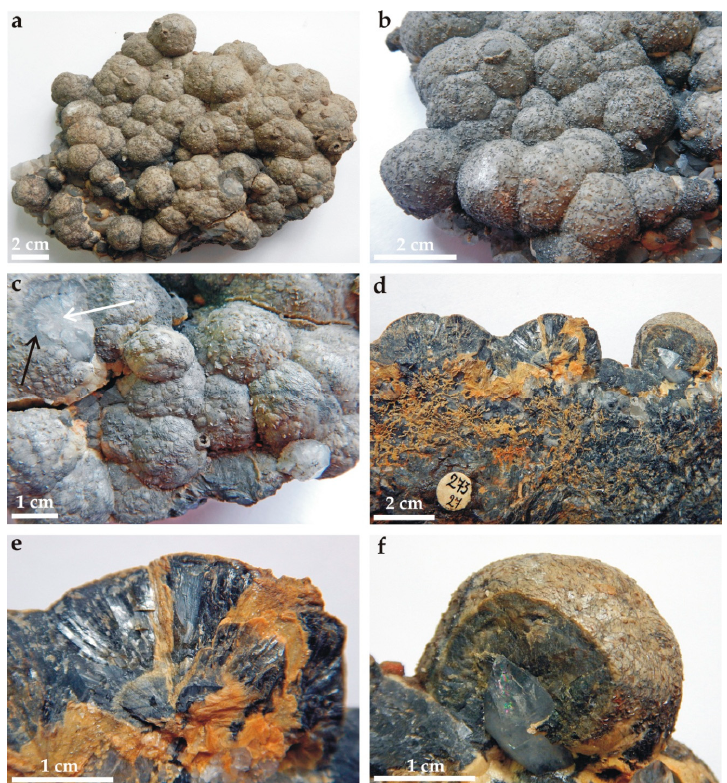
Figure 6. Attached black calcite spheres from Herja covered by siderite as continuous deposition layer, small hollow broken attached spheres, and minute euhedral crystals (sample 273/27, MMBBU). ( a ) General view of attached black calcite spheres covered by siderite; the black calcite is not visible; ( b ) Detail that highlights the shape of carbonate spheres and the presence of siderite wall remnants of a partly removed sphere; note the contrast between the imprint of the hollow broken sphere, and the rest of the specimen’s surface, which is covered by minute siderite crystals; a small sphere seems to be developed on a quartz crystal, which is not completely covered by carbonates; ( c ) Detail view focused on surface morphology that also shows a small broken sphere with crystal remnants in the inner space (lower part of the image); the arrows indicate the inner structure of a broken sphere with a central quartz crystal, covered by black calcite and thin siderite external sequence; ( d ) Cross-section through a series of three black calcite spheres, a dominant massive one (left), a fibroradial one (center), and one developed on a quartz crystal (right); ( e ) Detail of ( d ) that shows the fibroradial inner structure of the black calcite sphere with at least two concentric layers and the late siderite deposition at the surface and along fissures; ( f ) Detail of ( d ) that reveals the quartz crystal on which the massive black calcite sphere covered by siderite apparently formed.